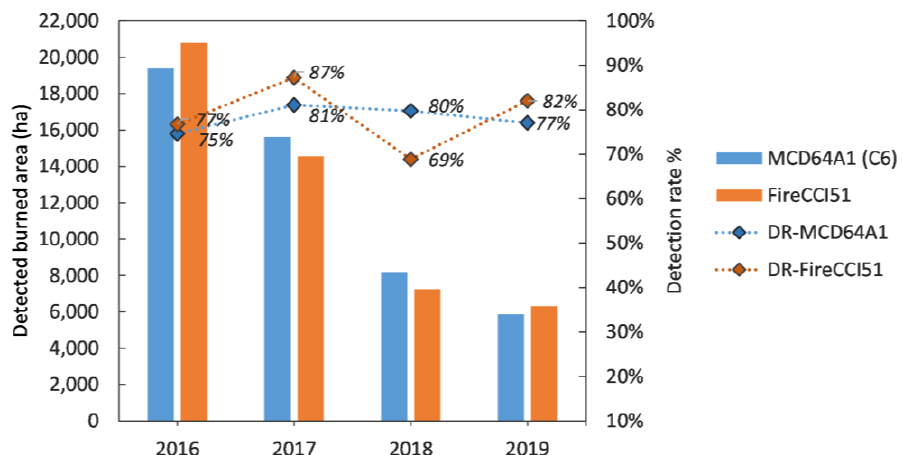
Figure 4. Annual estimations of correctly detected burned area (ha) in Greece and corresponding detection rates ( DR ) by the MODIS BA products.